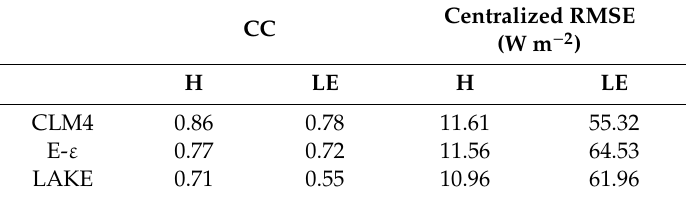
Table4. StatisticalvaluesofsimulationandobservationofsurfaceheatfluxinLakeTaihuinAugust2012.